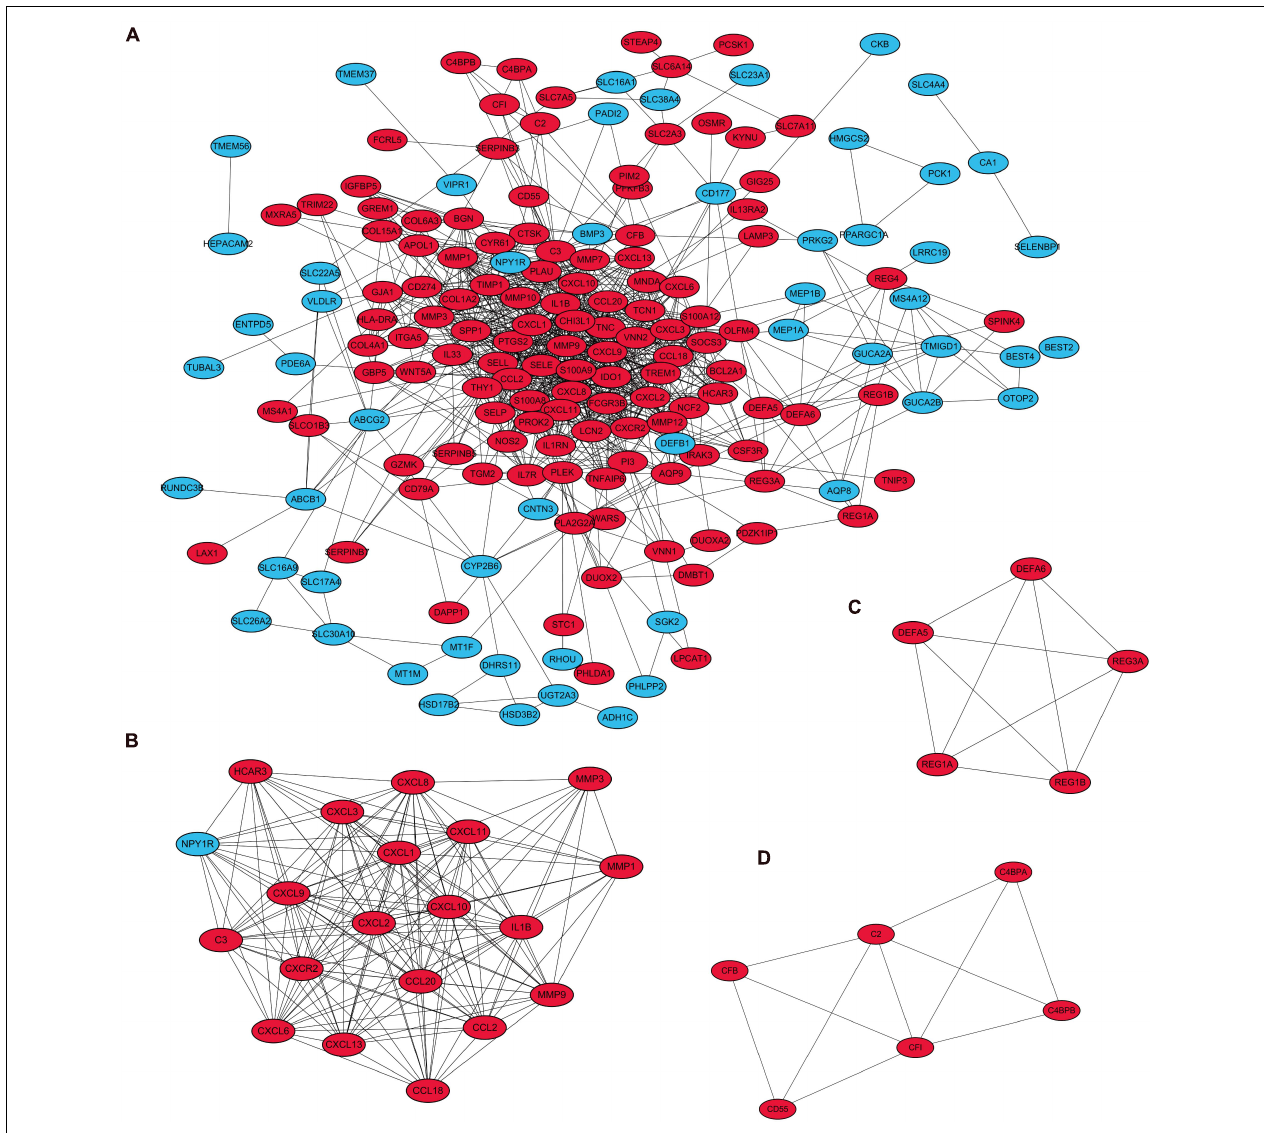
FIGURE 6 | Visualization and module identification of the PPI network. (A) A total of 208 DEGs were mapped using Cytoscape software. Three modules of the PPI networks were identified by the MCODE plug-in. (B) Module 1 comprised CXCL6, CXCL8, CCL18, C3, HCAR3, CXCL, CXCL13, IL1 β , NPY1R, MMP3, CCL20, MMP1, CXCR2, CCL2, CXCL1, CXCL10, CXCL9, CXCL3, and CXCL11 with the seed gene MMP9. (C) Module 2 contained DEFA5, DEFA6, REG3A, and REG1B with the seed gene REG1A, and (D) module 3 consisted of C2, C4BPA, CFI, CFB, and CD55 with the seed gene C4BPB. The red points represent upregulated genes, while the blue points represent downregulated